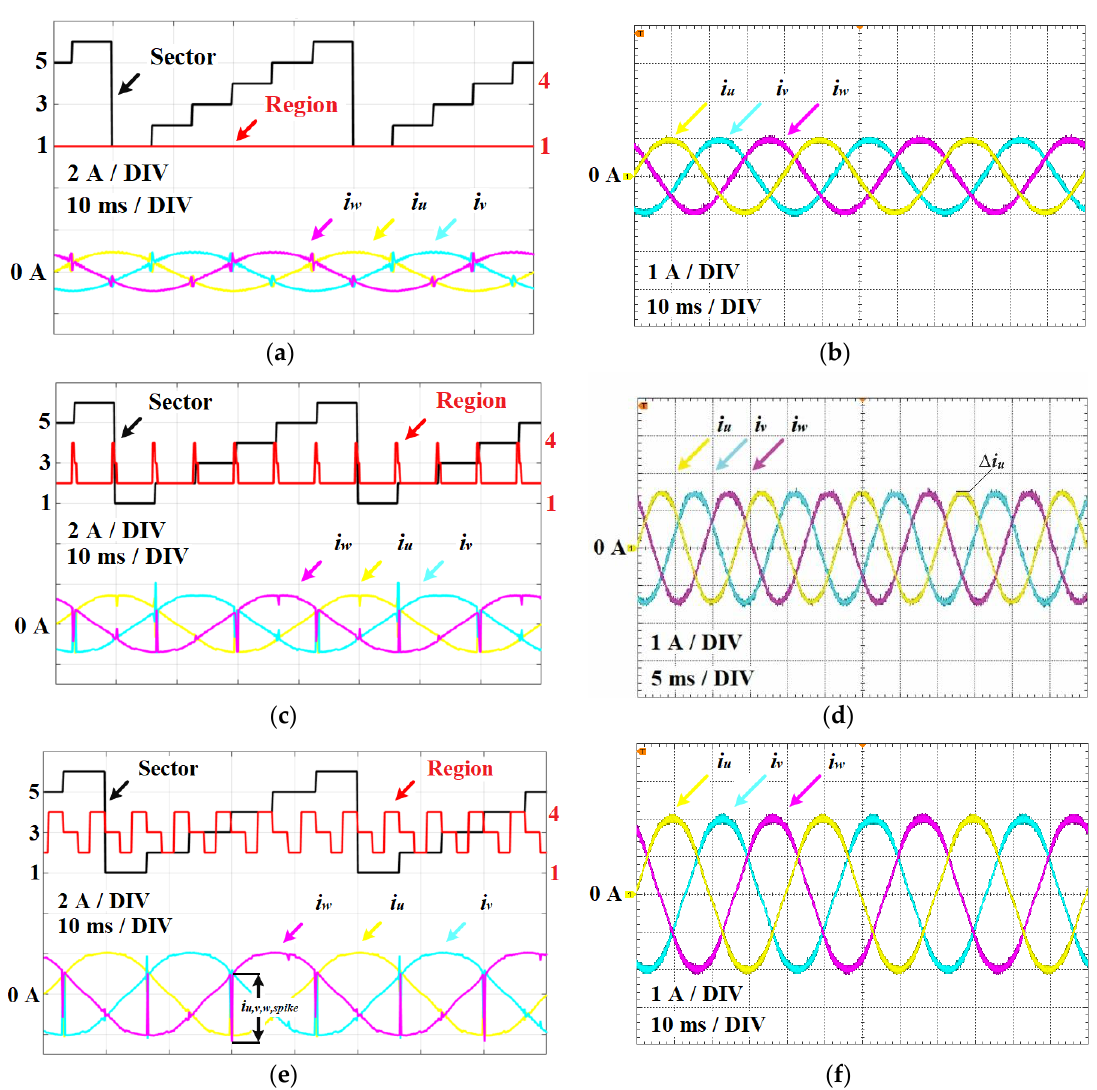
Figure 17. Single-shunt reconstruction of a three-phase current without SVM modification for f = 25 Hz: ( a ) m i = 0.4; ( c ) m i = 0.6; ( e ) m i = 0.8; scope-measured real three-phase currents for f = 25 Hz: ( b ) m i = 0.4; ( d ) m i = 0.6; ( f ) m i = 0.8.